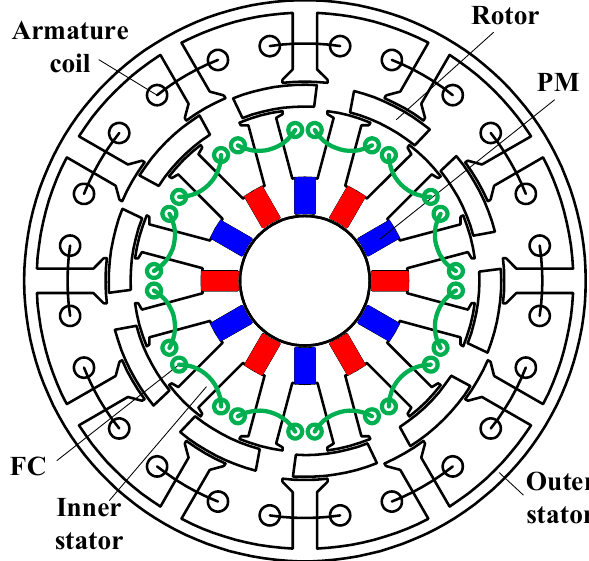
Figure 9. Cross section of a parallel stator ‐ excited HE machine with bipolar flux ( a ) with iron bridge for parallel coupling [45] and ( b ) without iron bridge for series coupling [47]. Figure 10. Cross section of a PS HE machine